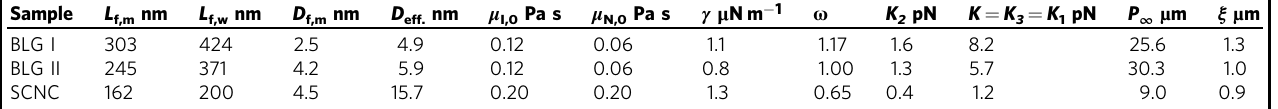
Table 1 Amyloid fi brils and cellulous nanocrystals suspensions properties obtained with experiments or calculated. Sample L f,m